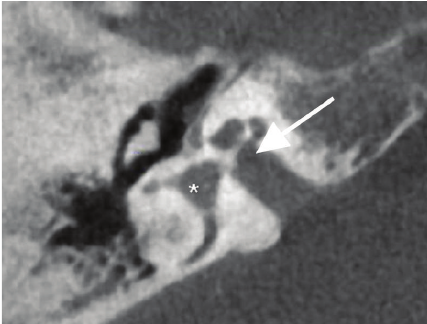
Figure 2: Axial noncontrast computed tomography of right tempo- ral bone reveals incomplete separation of the right internal auditory canal from the basal turn of the cochlea (arrow) and an enlarged vestibule (asterisk).